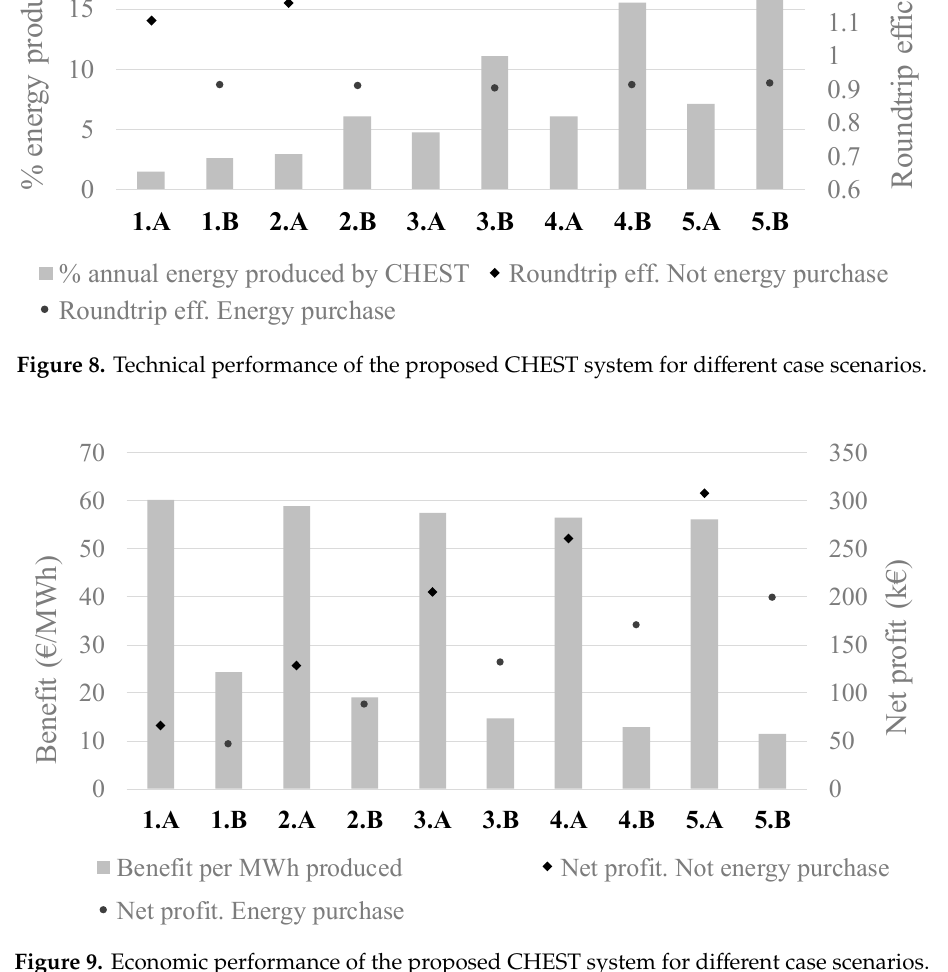
Figure 9. Economic performance of the proposed CHEST system for different case scenarios.